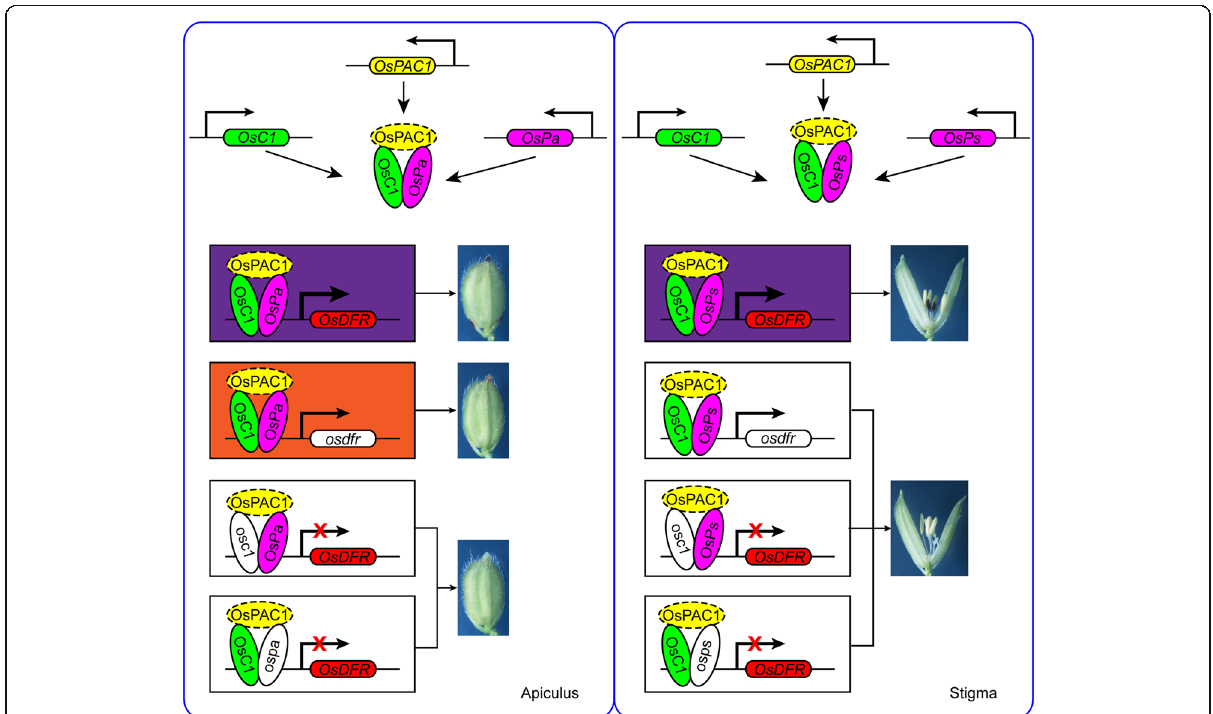
Fig. 9 Working models of apiculus and stigma coloration in rice. Both OsC1 and OsDFR had extremely high expression levels in both apiculus and stigmas, whereas OsPa and OsPs were more strongly expressed in the respective apiculi and stigmas. When all of OsC1 , OsDFR , OsPa and OsPs were functional the OsC1-OsPa-OsPAC1 and OsC1-OsPs-OsPAC1 complexes activated expression of OsDFR resulting in purple apiculi and purple stigmas, respectively. When OsC1 was not functional, it affected complex formation, therefore decreasing the expression of OsDFR and leading to non-pigmented apiculi and stigmas. When OsDFR was not functional, there was no stigma color and apiculi were brown. When OsPa or OsPs were nonfunctional, both apiculi and stigmas were non-pigmented. OsC1, OsPa and OsPs represented functional proteins corresponding to the products of OsC1 , OsPa and OsPs , respectively. osc1, ospa and osps represented nonfunctional products of the OsC1 , OsPa and OsPs loci, respectively. OsDFR and osdfr represented functional and nonfunctional OsDFR , respectively. Solid ellipse, interaction of the protein inside with the other had been confirmed; dashed ellipse, interaction of the protein inside with the other needed to